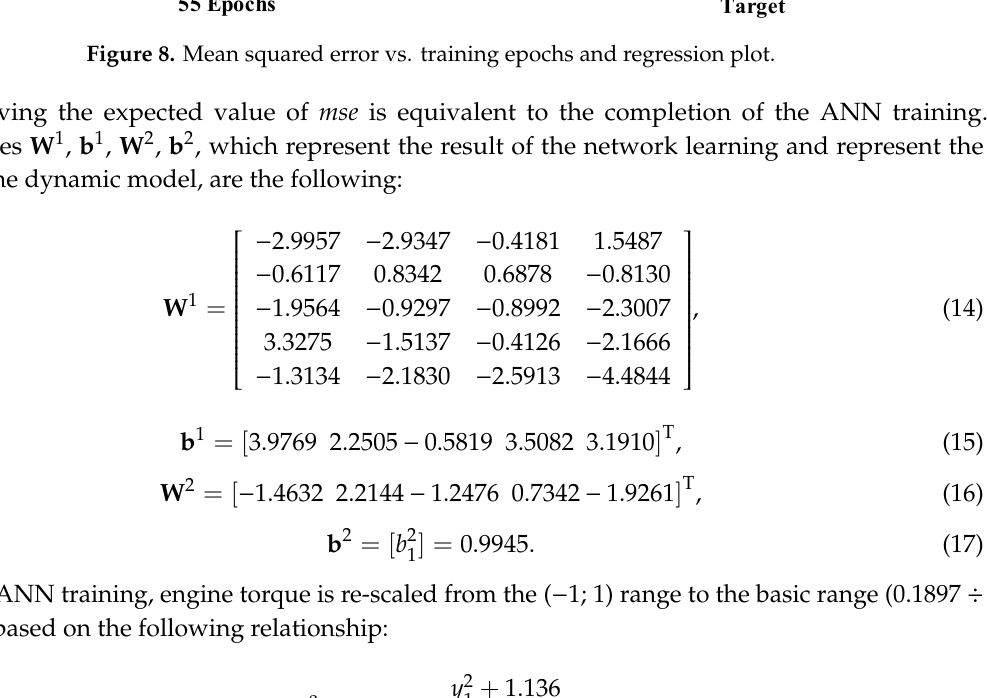
Figure 9. Engine efficiency characteristic in static states.